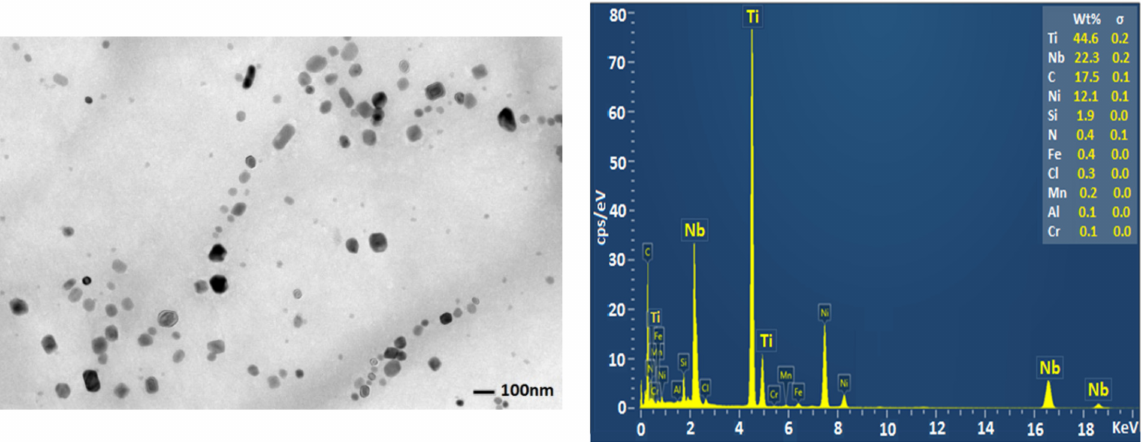
Figure 34. Nb-Ti carbo-nitrides found in a B containing high Al, TWIP tested at 1000 ◦ C, steel 1 in Table 4. The precipitates varied considerably in size (~80 nm in average size) but always gave similar composition. Composition of steel was 0.6% C, 18% Mn, 1.51% Al, 0.033% Nb, 0.075% Ti and 0.011% N. Cooling rate and strain rate were 60 K/min and 3 × 10 − 3 s − 1 , respectively